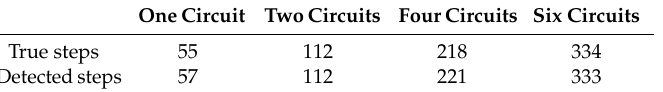
Table 2. The step detection result of the PDR algorithm.